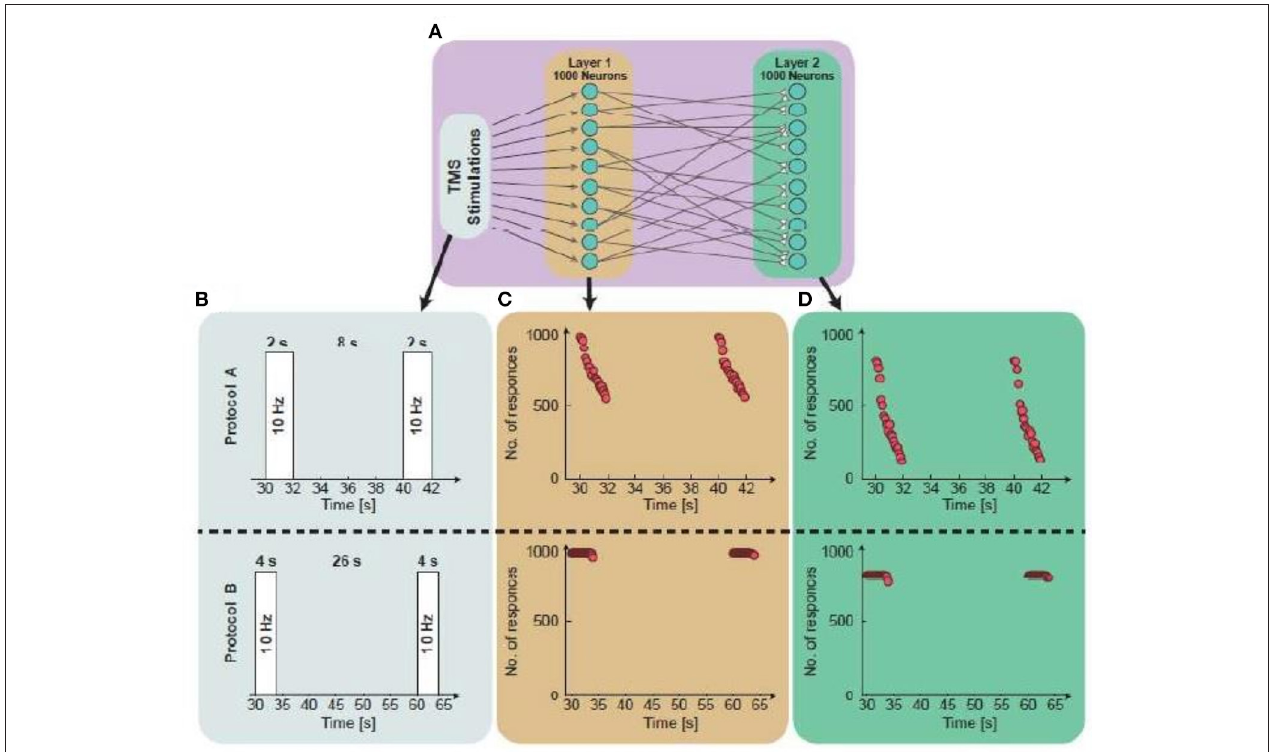
FIGURE 3 | Simulations from a single neuron to population dynamics. (A) A scheme of the simulated two-layered feed-forward network: Two populations, 1st layer is randomly connected presynaptically to the 2nd layer. Each layer consists of 1,000 neurons and the 1st layer is stimulated repeatedly. (B) An illustration of the simulated protocol. Upper panel: Neurons in the 1st layer are stimulated at 10Hz for 2s, every 10s. Lower panel: Neurons in the 1st layer are stimulated at 10Hz for 4s, every 30s. (C) The number of firing neurons in the 1st layer as a function of the stimulation time. The average number of responses in the 1st layer for protocol A and protocol B is 0.75 and 0.999, respectively. (D) The number of firing neurons in the 2nd layer as a function of the stimulation time. The response probability in the 2nd layer for protocols A and B is 0.44 and 0.85, respectively.